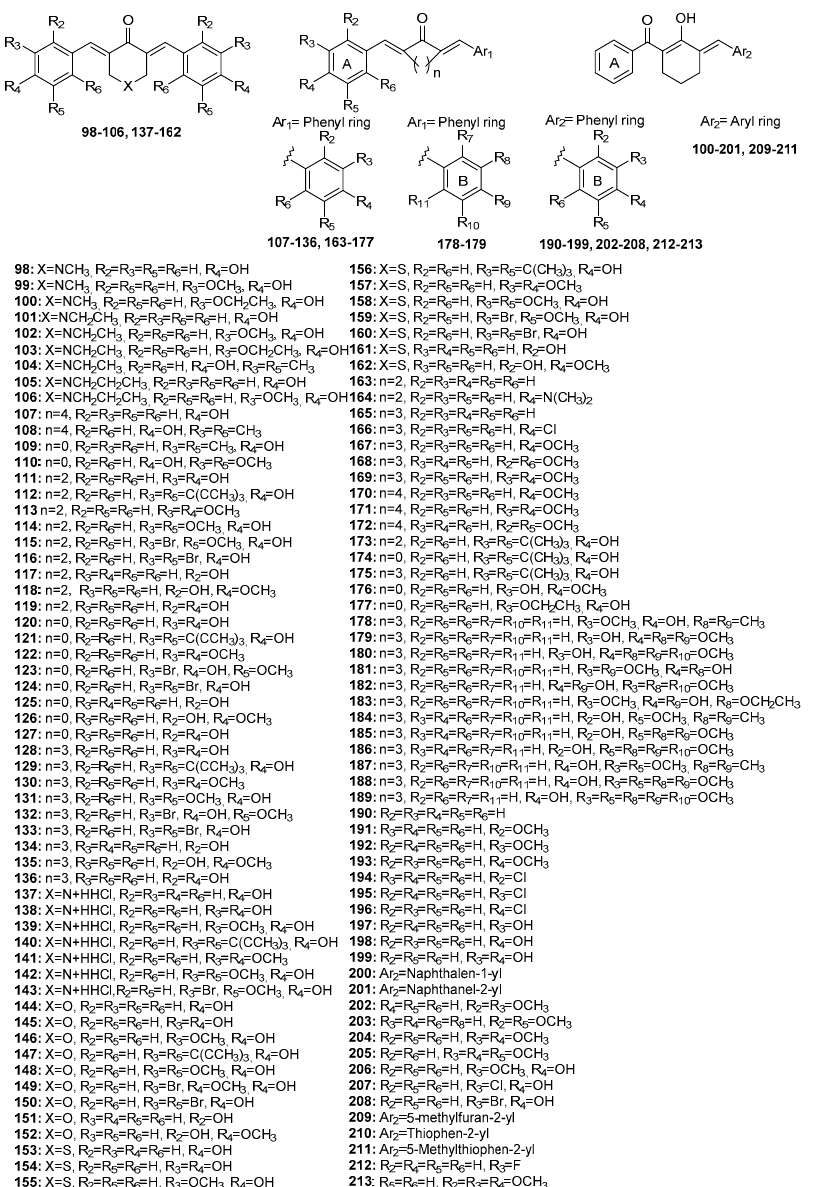
110 , 120 , 122 , 123 , and 174 : Figure 6), cyclohexanone ( 33 and 34 : Figure 3; 128 , 130 – 132 , and 175 : Figure 6), and piperidone ( 137 – 140 , 133 , and 143 : Figure 6) moieties, and evaluated their DPPH scavenging effect. It was observed that compounds 111 , 120 , 128 , and 138 were clearly the most active (IC 50 < 3 µ M) comparing to the positive control’s vitamin C and curcumin ( 1 ). All results indicated that, when the para -position has a hydroxyl group, DPPH scavenging activity depends significantly on the introduction of electron-donating groups (hydroxyl and methoxy) in the meta -position (Figure 7). It is obvious that the replacement of hydroxyl with methoxy in the para -position ( 113 , 122 and 130 ) significantly decreases activity (IC 50 > 800 µ M) (Figure 7). Moreover, the results showed that the meta - substitution of the aromatic rings by hydroxyl groups is more favorable for activity than substitution by methoxy groups. However, the presence of methoxy groups is associated with a higher effect than the presence of t -butyl groups, which are also more favorable for activity than bromine (Figure 7). Interestingly, when comparing compounds with different central moieties but the same substitution pattern regarding aromatic rings, no significant differences are observed in scavenging activity [35].